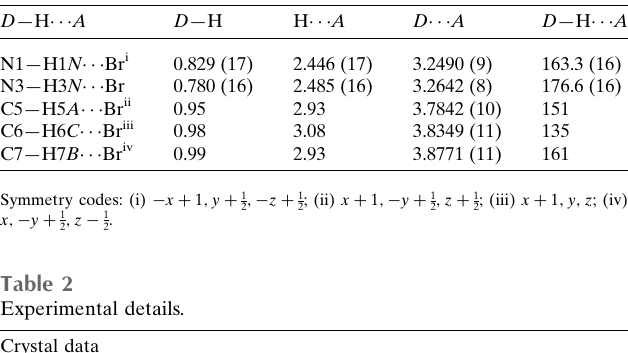
Table 1 Hydrogen-bond geometry (A˚ , (cid:4) ).